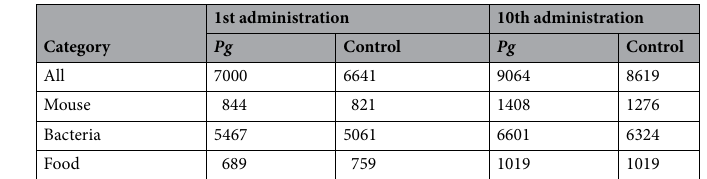
Table 4. Number of peptides detected during the proteome profiling of the feces of the Porphyromonas gingivalis ( Pg )- and carboxymethyl cellulose-treated db / db mice. There was no statistical difference in the number of peptides detected, between the Pg - and CMC control-treated